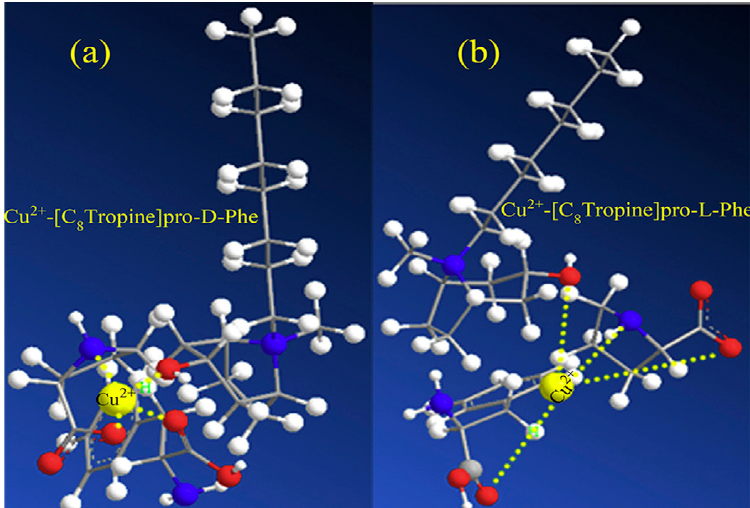
Figure 7. Structures and interaction of the ternary complex of Cu 2+ -[C 8 Tropine]pro-D-Phe ( a ) and Cu 2+ -[C 8 Tropine]pro- L -Phe; ( b ) yellow dotted lines represent the electrostatic interaction and the